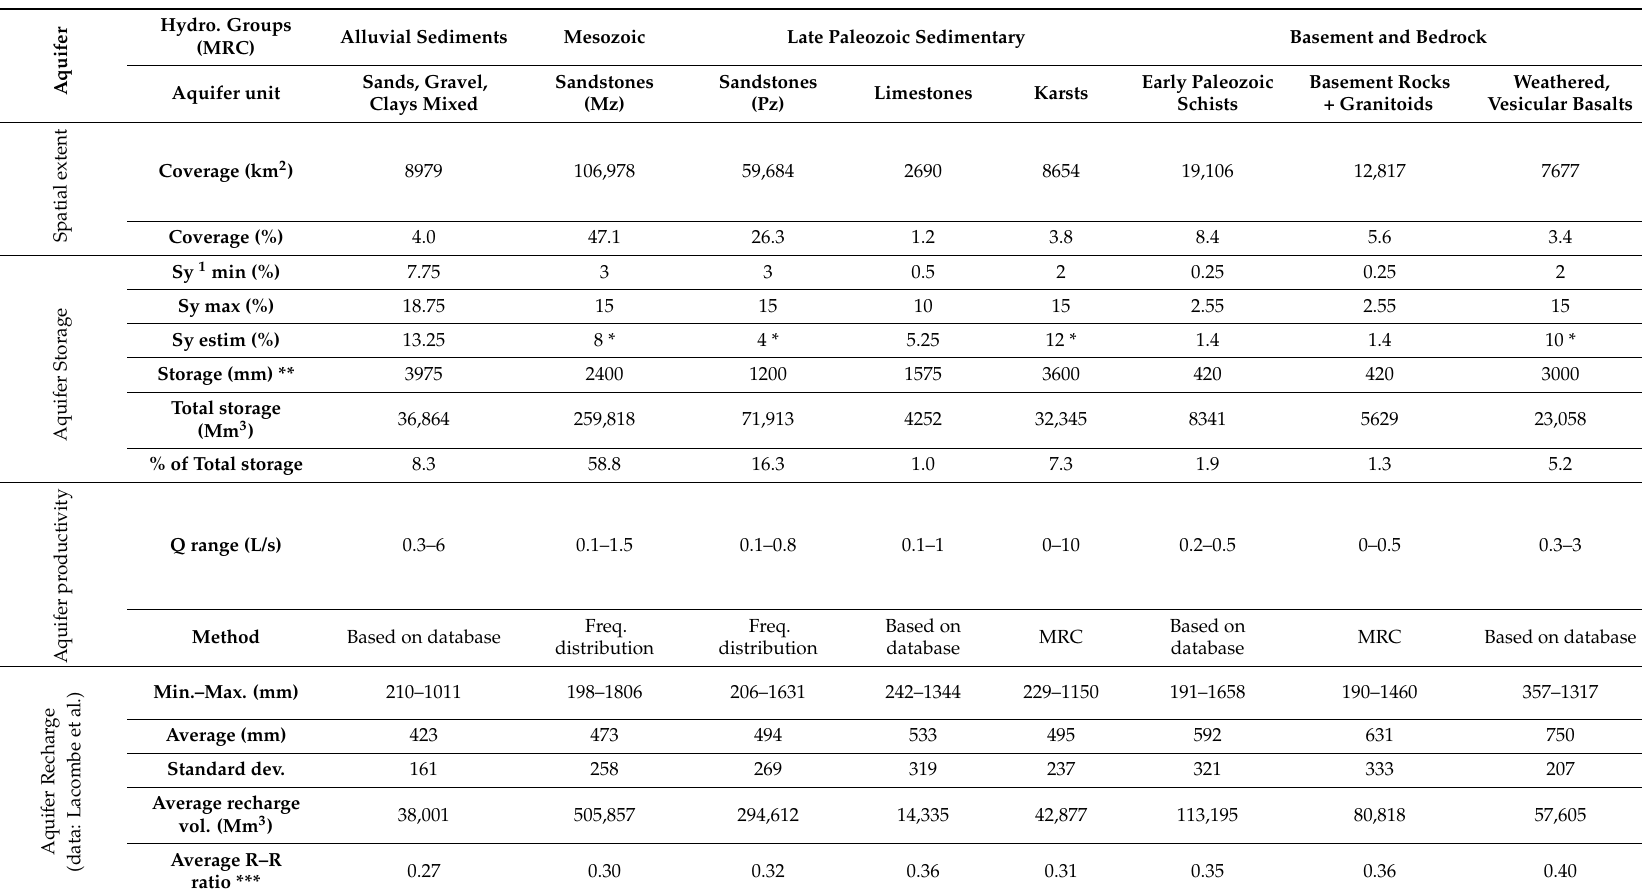
Table 3. Comprehensive table of aquifer unit-level groundwater potential